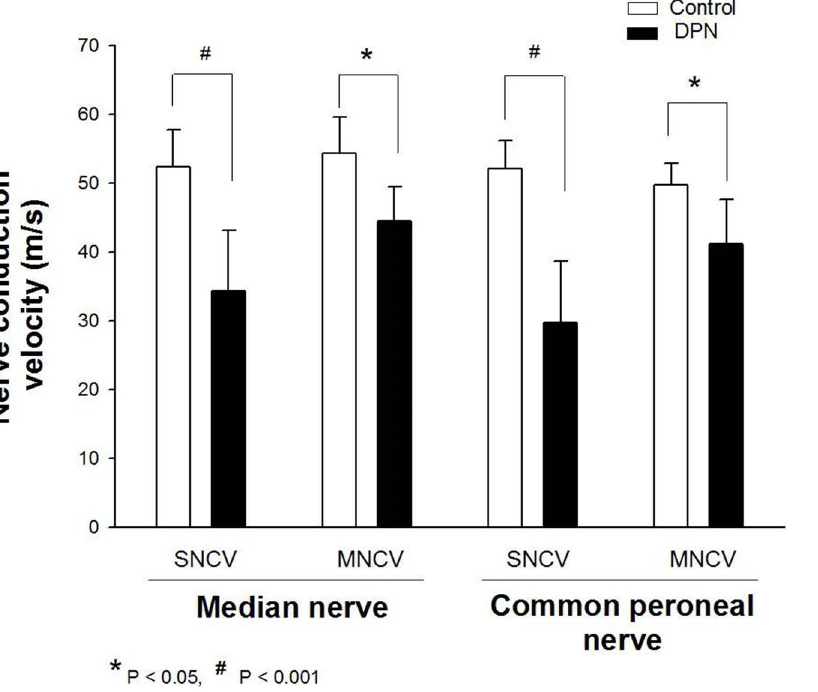
Figure 1. Assessment of nerve conduction velocity (NCV) was performed in controlled group and experimental group. The SNCV and MNCV of both the median and common peroneal nerves have shown a statistical significant reduction in DPN groupcompared with controlled group.